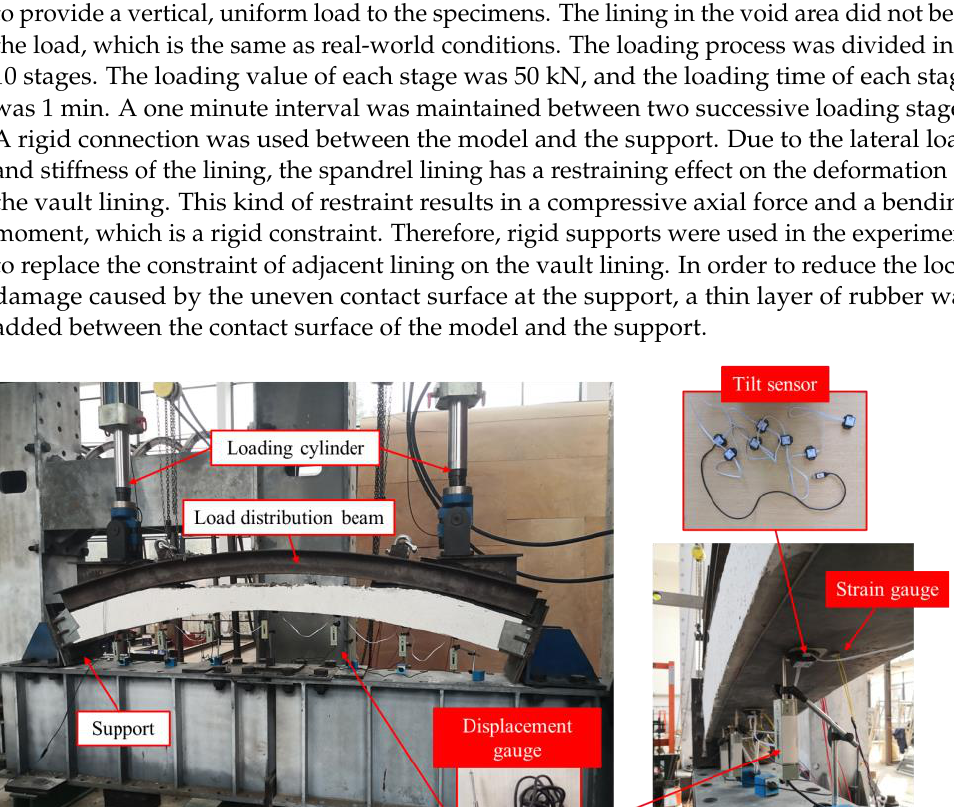
Figure 2. Steel plate strengthening scheme.